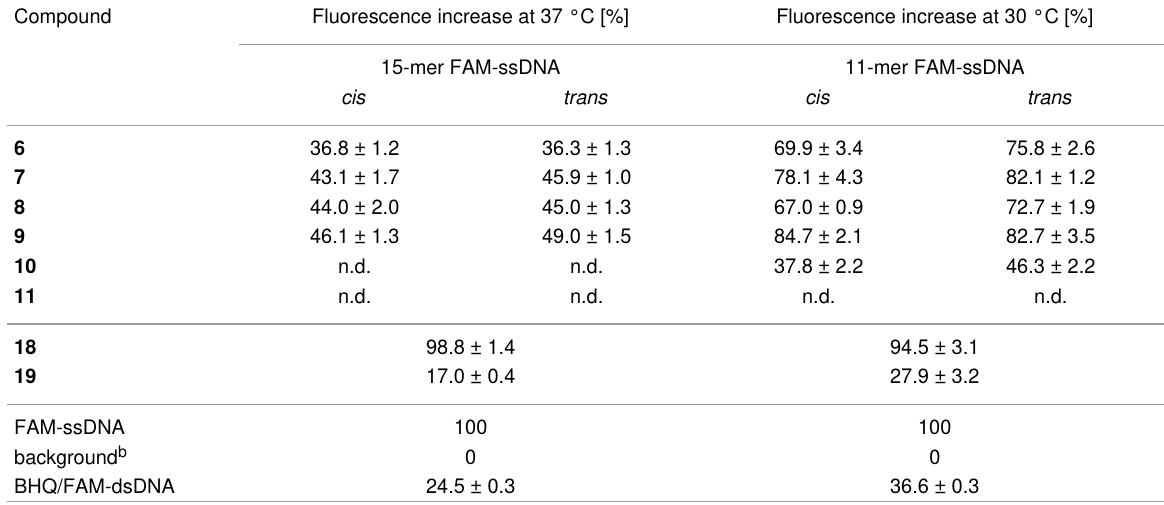
Table 3: Normalized increase of fluorescence signal derived from the strand-displacement assays. a Compound